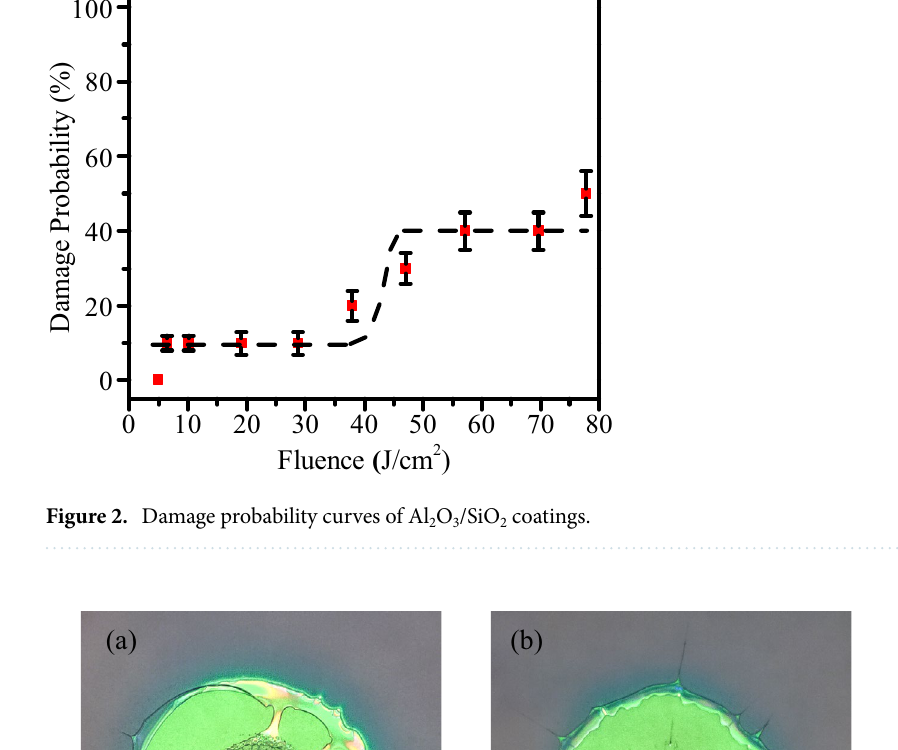
Figure 5 indicates that the size of the damage pit changes with the laser energy. Some damage pits of sample I and II are observed at relatively low energy, which are relatively small, especially sample I. Sample III is not damaged at relatively low energy, so no damage point was observed at relatively low energy. The damage pit size becomes significantly larger after energy above about 20 J/cm 2 , and with the increase of energy, the development of damage pit size approaches a linear increase. Under the same laser energy, sample I has the largest damage pit size, and sample III has the smallest size. This is related to the thermodynamic properties of the film composition of the samples, which will be explained in detail later.